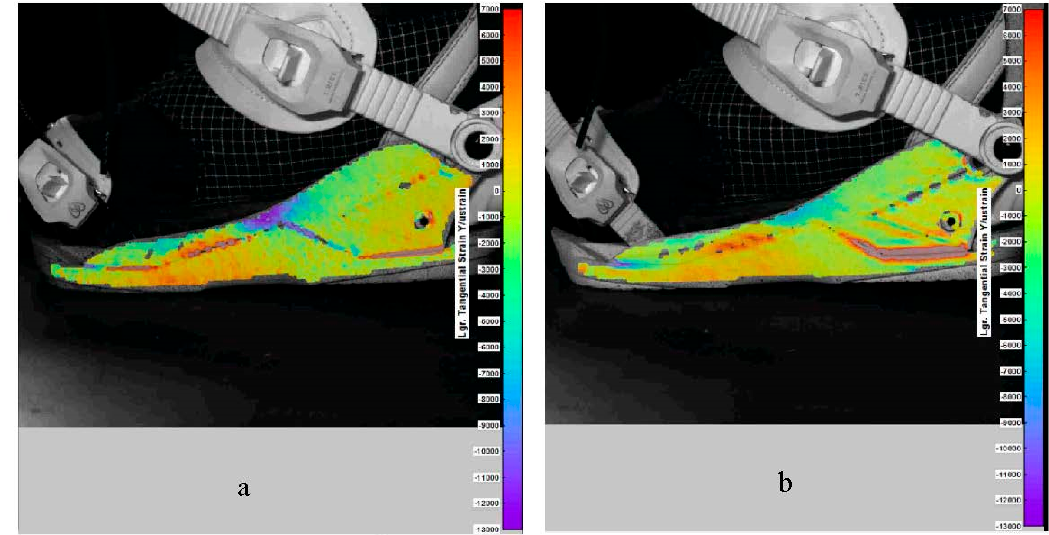
Figure 3. Comparison of deformations (horizontal axis) of a commercial baseplate made by injection molding ( b ) and a baseplate 3D printed ( a ) at 250 N, applied on the upper part of the prosthesis in dorsiflexion.